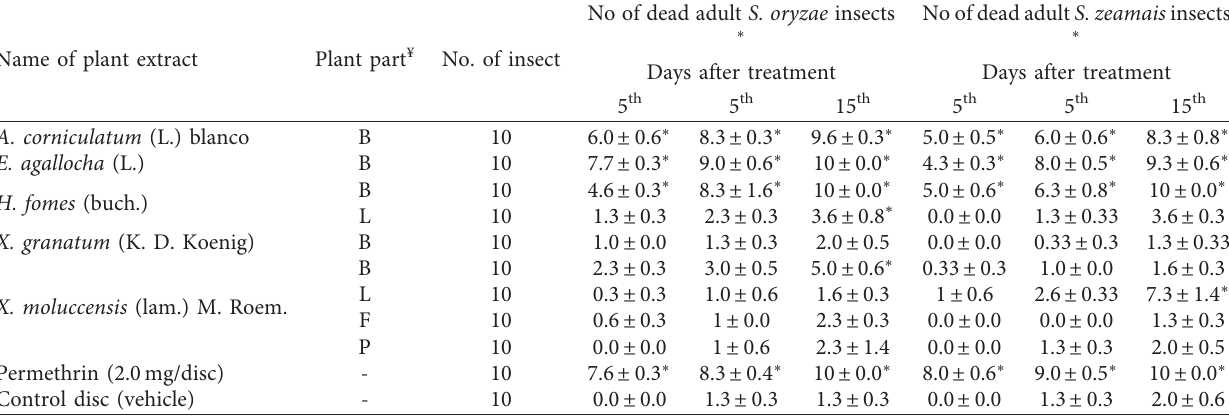
Table 2: Insecticidal activity of the methanolic crude extract of Sundarban plants against S. oryzae and S. zeamais insects at 2.5 mg/disc concentration.